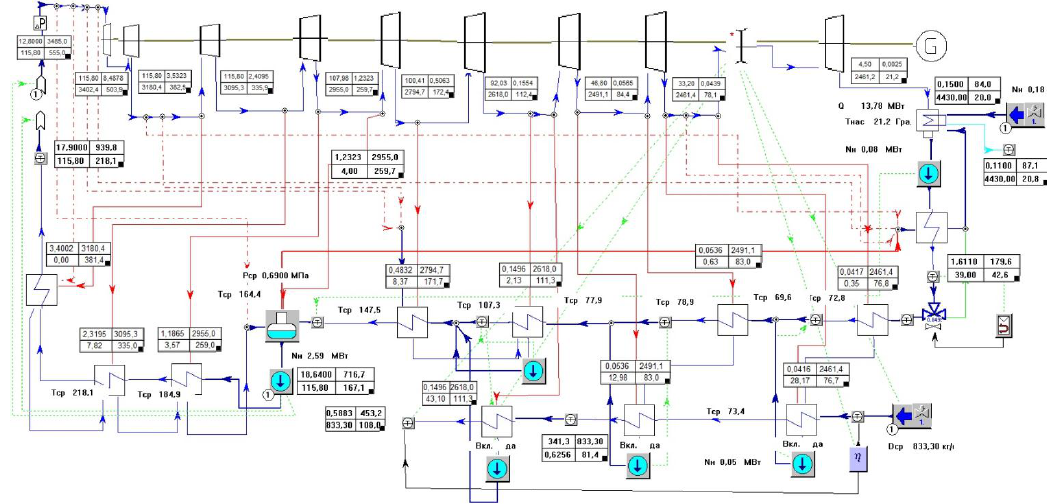
Figure 2. Thermal design with three inline reheaters and rotary diaphragm controlling the heat supply.